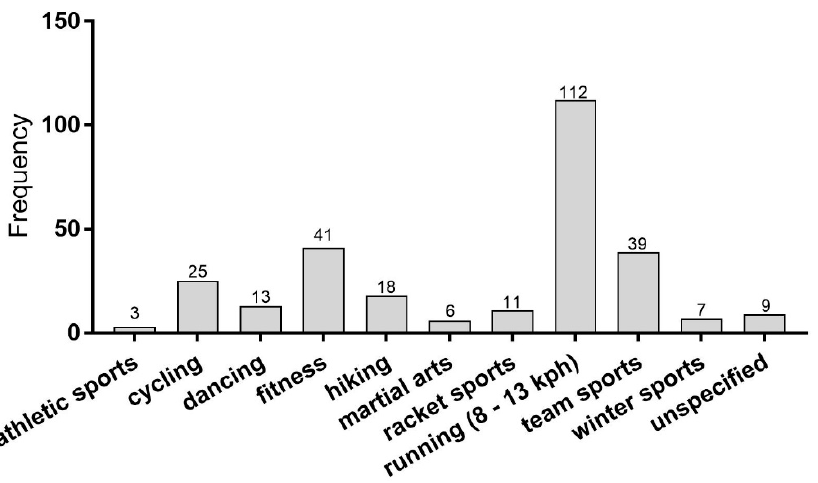
Figure 2. Absolute number of pain-causing activities. Data show the absolute case number (multiple answers possible). kph, kilometers per hour.